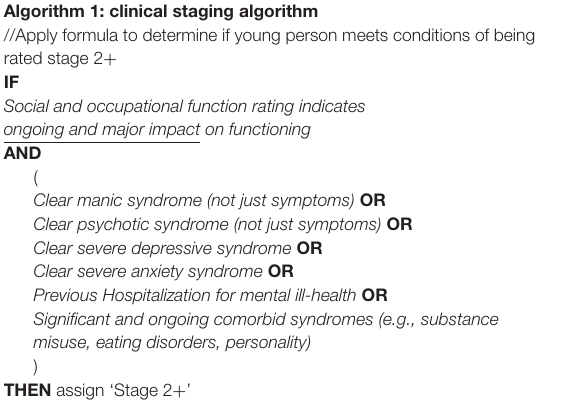
TABLE 2 | Pseudocode for the translation of clinical staging decisions into an algorithm. Algorithm 1: clinical staging algorithm //Apply formula to determine if young person meets conditions of being rated stage 2 +